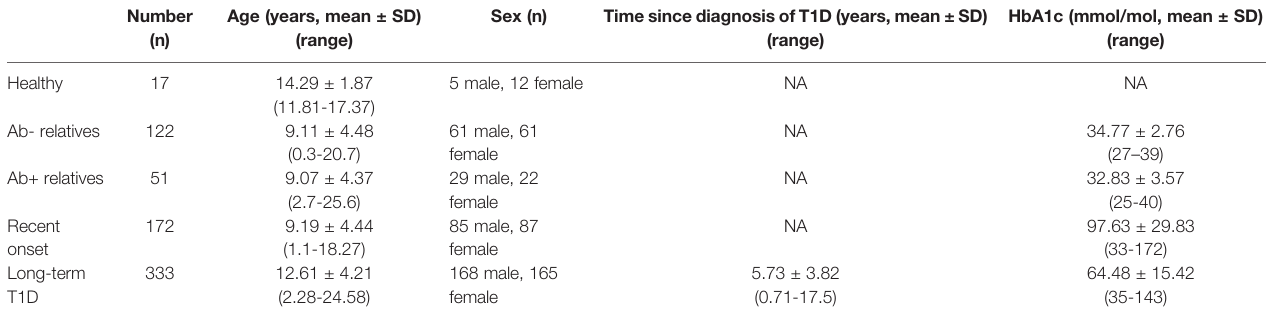
TABLE 1 | Cohort description – neutrophil